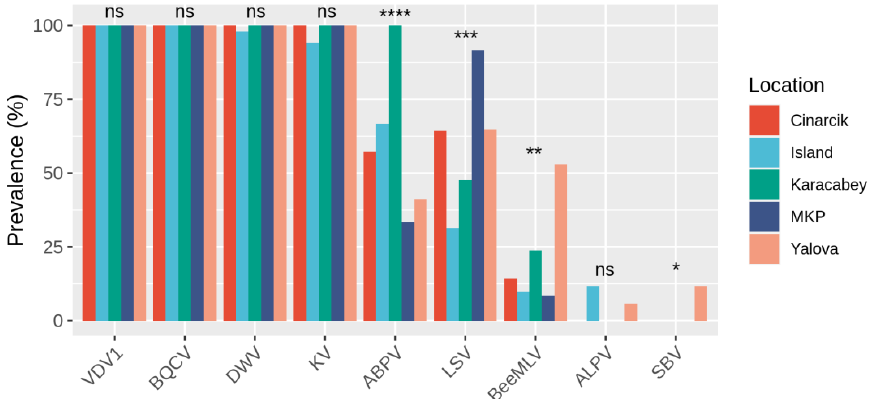
tected in 11.76% of colonies located in Yalova (Figure 3).